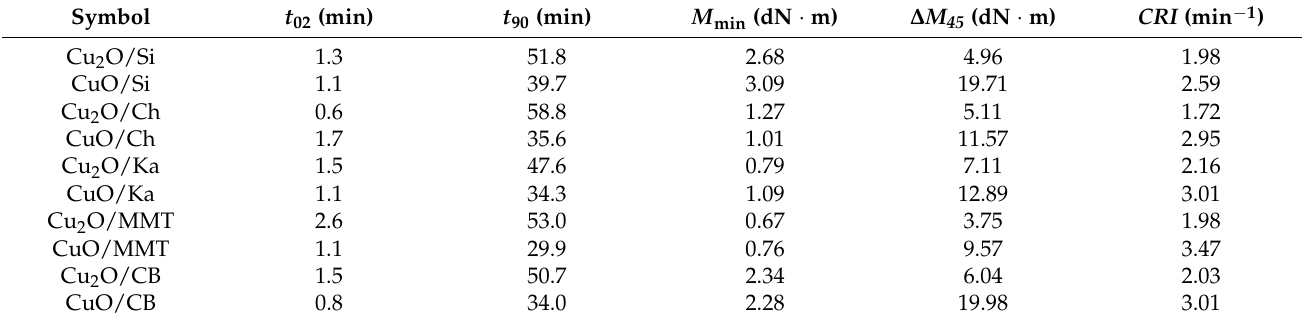
Table 2. Vulcametric parameters of the filled CR compositions determined at the temperature of 160 ◦ C.